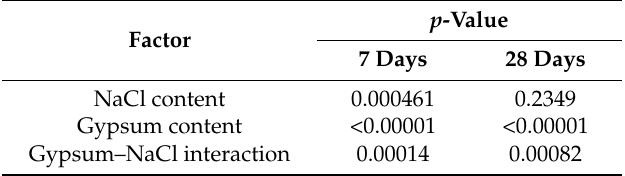
Table 3. p -values for the compressive strengths of hardened paste samples.